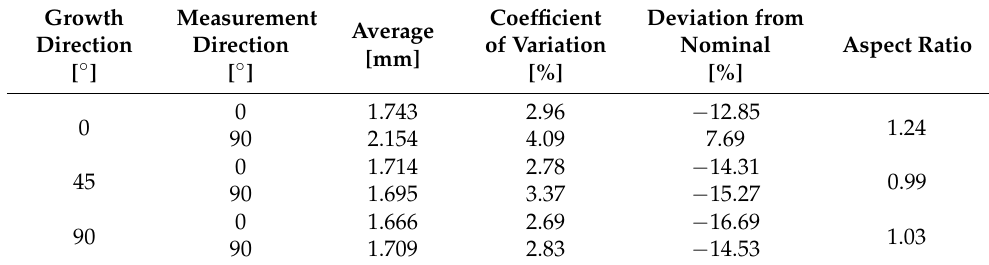
Table 2. Influence of the measurement